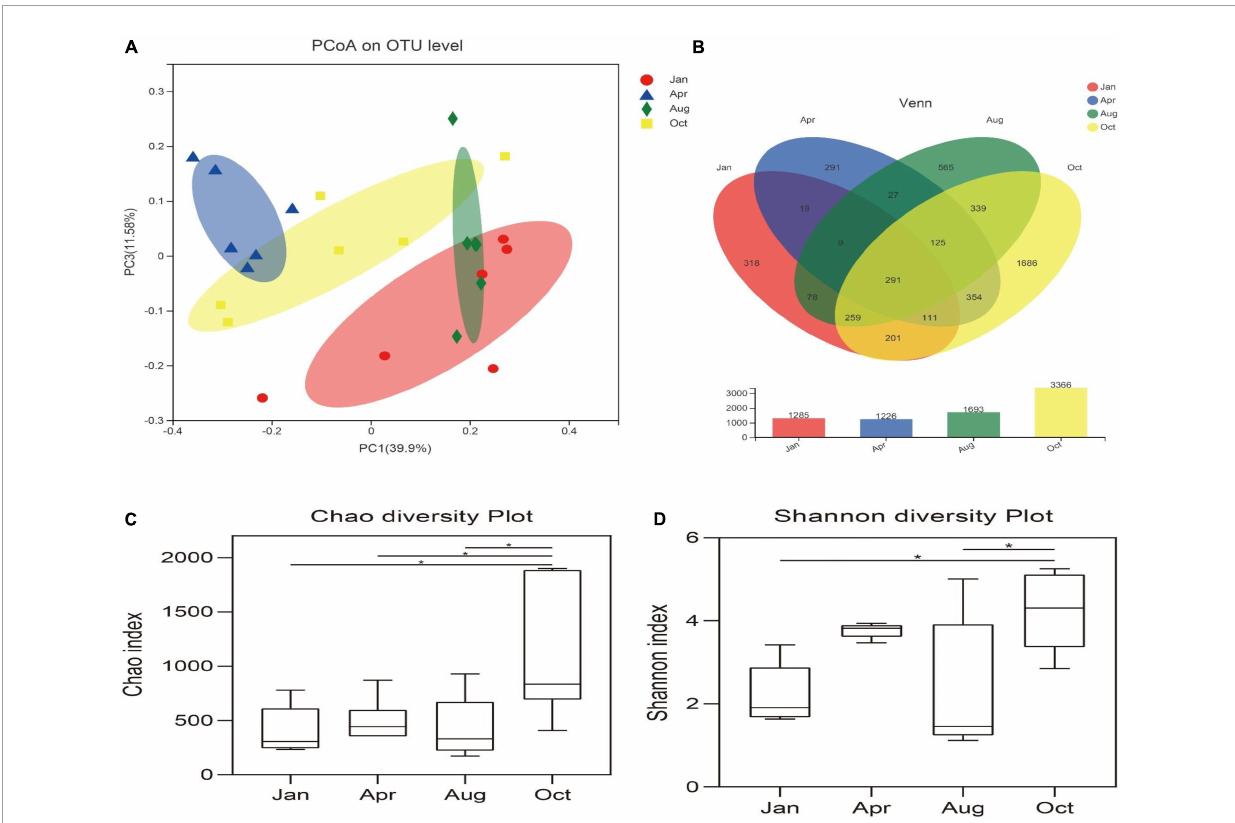
FIGURE2 Diversity of gut microbes. (A) Principal co-ordinates analysis (PCoA) was performed at the OUT level based on weighted UniFrac distances for all samples. Different colored dots in the figure represent different groups. The x-axis and y-axis (PCoA1 and PCoA3) represent 33.9 and 11.58% of the variance, respectively. (B) Venn diagram represents sharing and unique OUT in Jan, Apr, Aug, Oct. Histograms represent the total number of OUT for each group. (C) Chao index indicates community distribution abundance. (D) Shannon index indicates diversity in community distribution. * p <